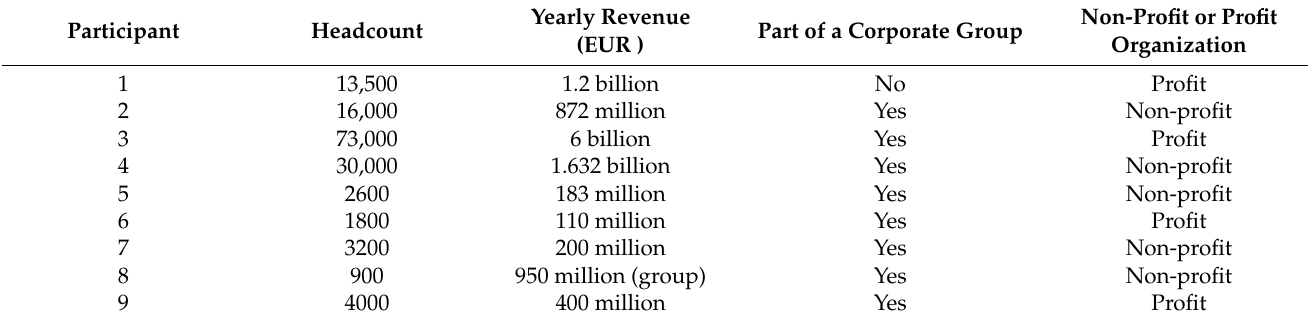
Table 2. Characteristics of the corporations participating in the